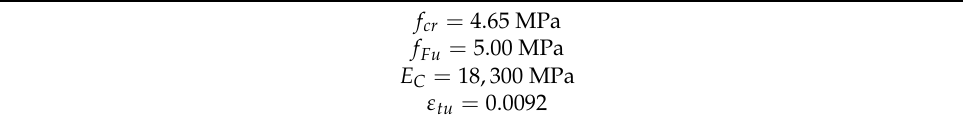
Table 4. Inverse analysis